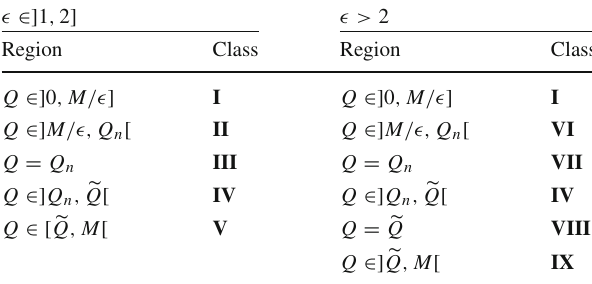
Table 4 Classification in terms of the charge-to-mass ratio (cid:2) > 1 of the circular orbits of a charged test particle moving in the field of a RN black hole with mass M and charge Q